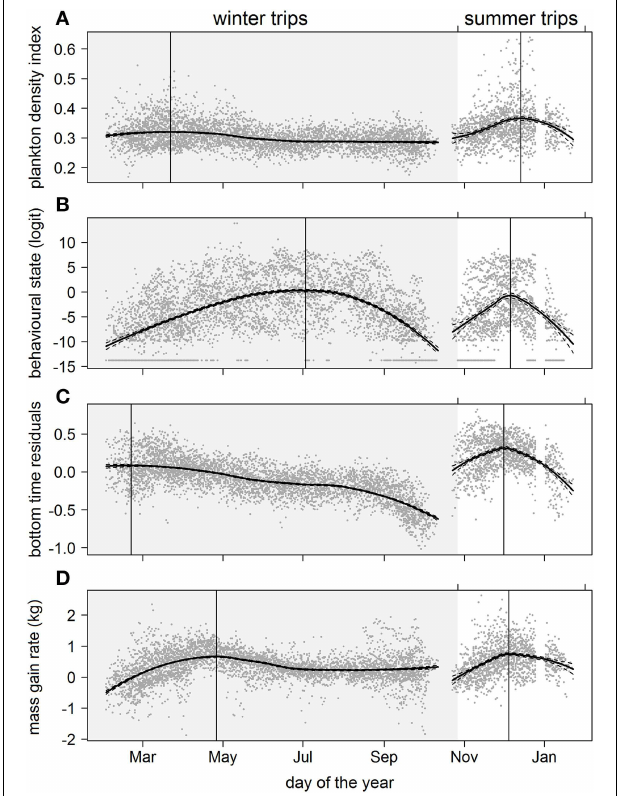
FIGURE 5 | Seasonal trends over multiple years of (A) plankton densities encountered, (B) behavioral state, (C) dive effort, and (D) foraging success during the summer (non-shaded area) and winter (shaded area) foraging trips. Data values are represented by dark gray points. A locally-weighted polynomial regression smoother function applied to PDI and behavioral values using the R software package stats (function lowess; R Development Core Team, 2013). The loess fit and gray dashed lines represent the 95% confidence level. Vertical lines indicate the temporal peak for each measured metric.